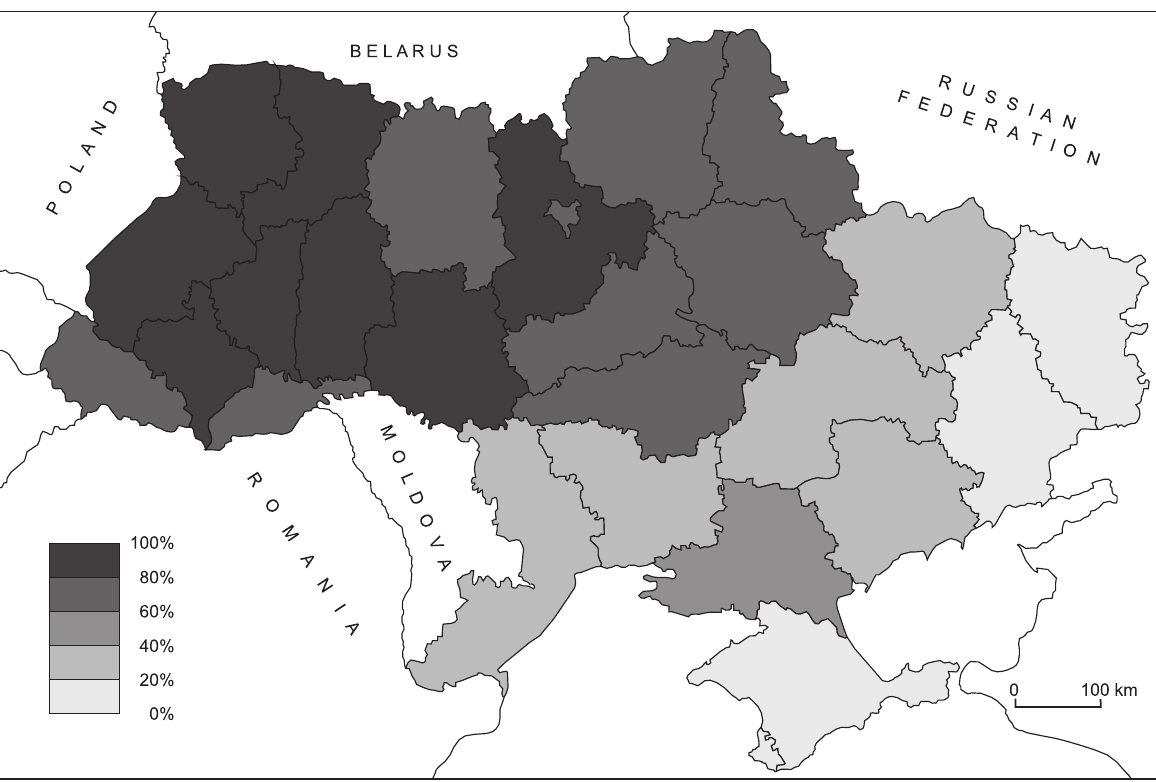
Fig. 3. Percentage of votes in Yushchenko’s support at the 2005 presidential election Source: http://www.cvk.gov.ua/pls/vp2004/wp0011